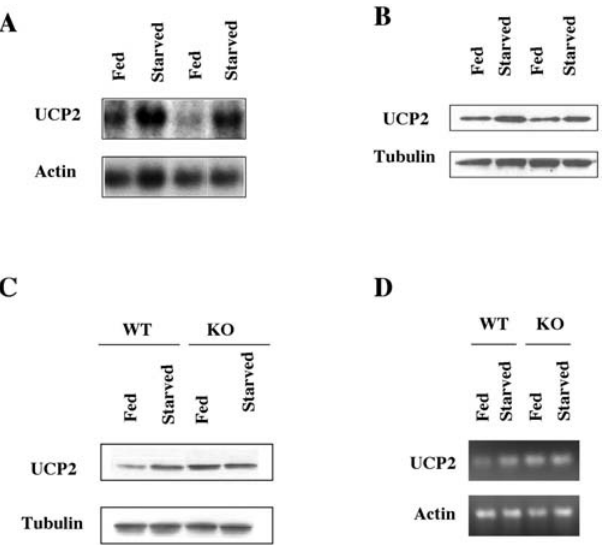
Figure 7. UCP2 mRNA or Protein Levels in Fed or Starved Wild-Type Mice (A) Northern blot for UCP2 in whole pancreas of two ad libitum mice and two mice starved for 18 h. (B) Western blot for UCP2 in isolated islets in two ad libitum and two starved mice. (C) Western blot for UCP2 in wild-type (WT) or Sirt1 KO littermates either fed ad libitum or starved for 18 h. The experiment shown is representative of four pairs of wild-type and KO littermates analyzed. (D) RT-PCR for UCP2 in wild-type or Sirt1 KO mice fed or starved. DOI: